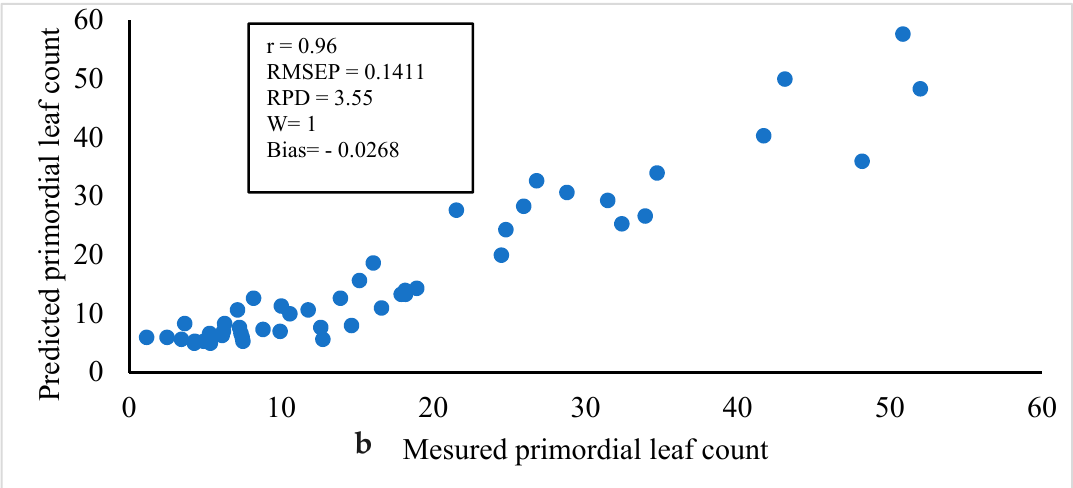
Figure 4. Relationship between measured and predicted primordial leaf count using combined VIS/NIR interactance spectroscopy and VIS/NIR hyperspectral imaging for ( a ) Frito Lay1879 and ( b ) Russet Norkotah.